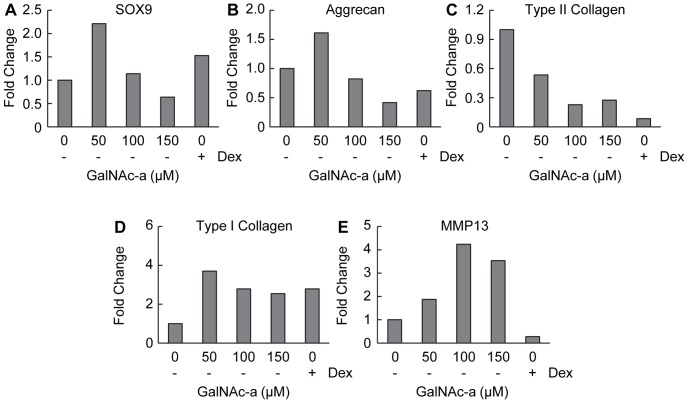
Gene expression analysis of MSCs undergoing chondrogenesis in the presence of ascorbic acid and GalNAc-a or dexamethasone in 3D hydrogels.Markers for (A-D) chondrogenesis and matrix production and (E) MMP13 were evaluated. All data were normalized to individual β-actin levels and presented relative to untreated controls (no analog, no dexamethasone).